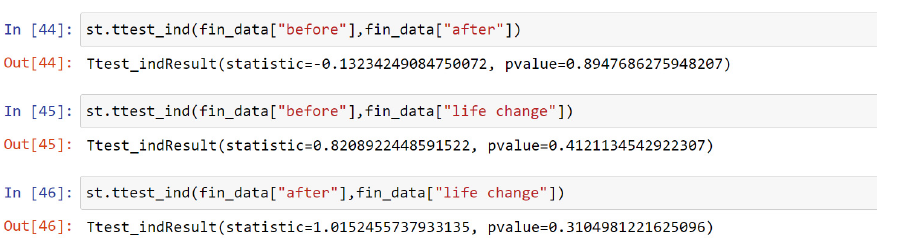
Figure A7. Two-sample paired t-test calculation via Jupyter Notebook and statistical functions (scipy.stats). Source: own research.